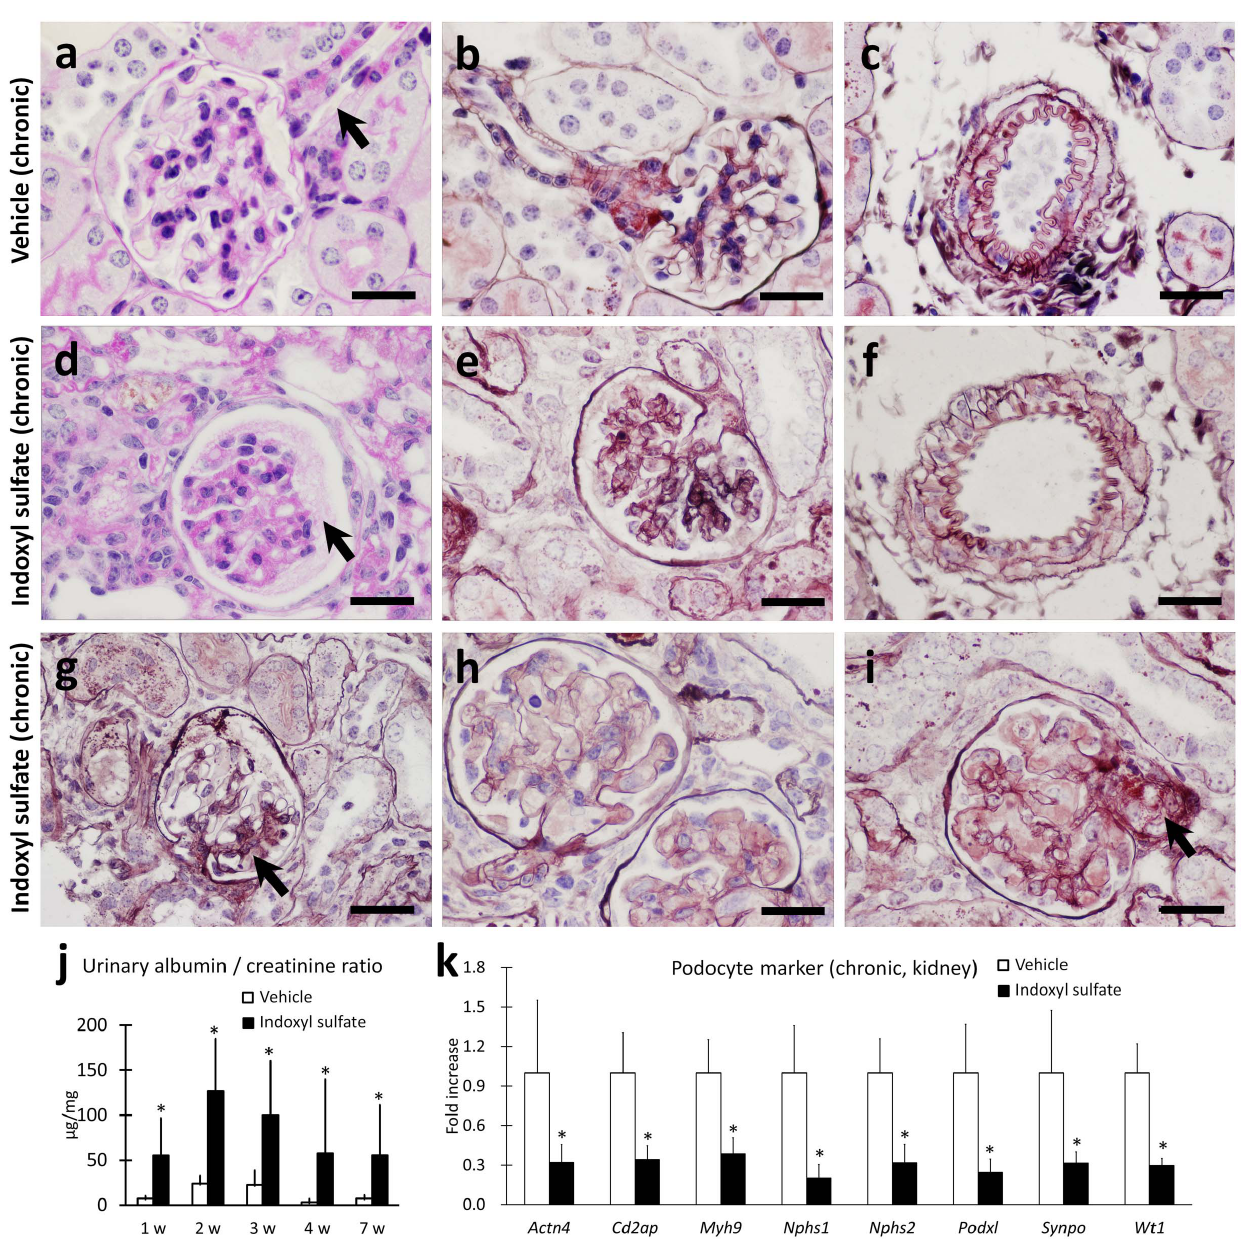
Figure 2. Indoxyl sulfate induced glomerular and microvascular injuries in mouse kidneys. Shown are representative images from FVB/N mice exposed to vehicle ( a – c ) or indoxyl sulfate (600 mg/kg, i.p. for 8 w), ( d–i ). In comparison to histologically unremarkable glomeruli ( a ), arterioles ( a , arrow, and b ) and arteries ( c ) in vehicle-exposed mice, glomeruli in indoxyl sulfate-exposed mice showed ischemic changes ( d and e ) and protein exudate in Bowman’s space ( d , arrow). In the more severely injured kidneys, glomeruli with increased mesangial matrix/segmental solidification were noted ( g , arrow). In the kidneys with more severe injury, occasional glomeruli with mesangiolytic features were present ( h and i ). Histologically unremarkable mid-sized artery in vehicle-exposed mice, reduplication of elastic lamina mid-sized artery in indoxyl sulfate-exposed mouse are shown ( f ). Occasional glomerular arterioles demonstrated arteriosclerosis ( i , arrow). Bars=20 m m. The urinary albumin/creatinine ratio (n $ 7, mean 6 SD) is shown in ( j ); W denotes weeks after dosing. Podocyte marker mRNA expression in mouse kidneys is expressed as a fold change compared to the vehicle control ( k ); n $ 3, mean 6 S.D. * denotes significant differences between the vehicle and indoxyl sulfate groups in the same experiment ( P , 0.05). doi:10.1371/journal.pone.0108448.g002 24 h with 0.1 mM indoxyl sulfate and for 72 h with 1.0 mM indoxyl sulfate (Figure 5d). Using immunofluorescence staining (Figure 5e), we observed scant AhR protein in the nucleus or in perinuclear areas of DMSO control podocytes. Following 1.0 mM indoxyl sulfate exposure,